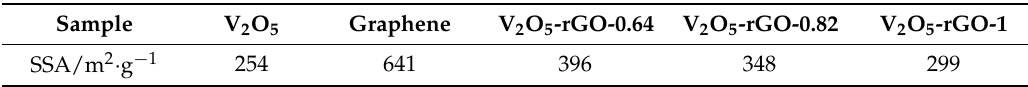
Table 1. BET-specific surface area of the V 2 O 5 , graphene, and V 2 O 5 -rGO hybrid aerogels prepared by Method I.